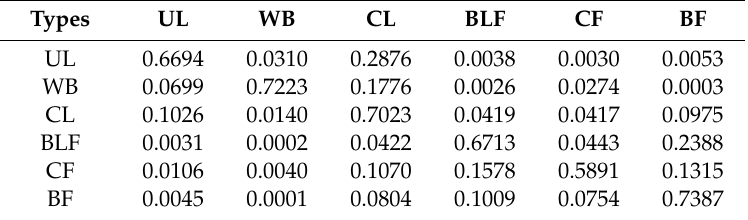
Table 6. The average transition probability matrix from 2004 to 2014 in Anji County.